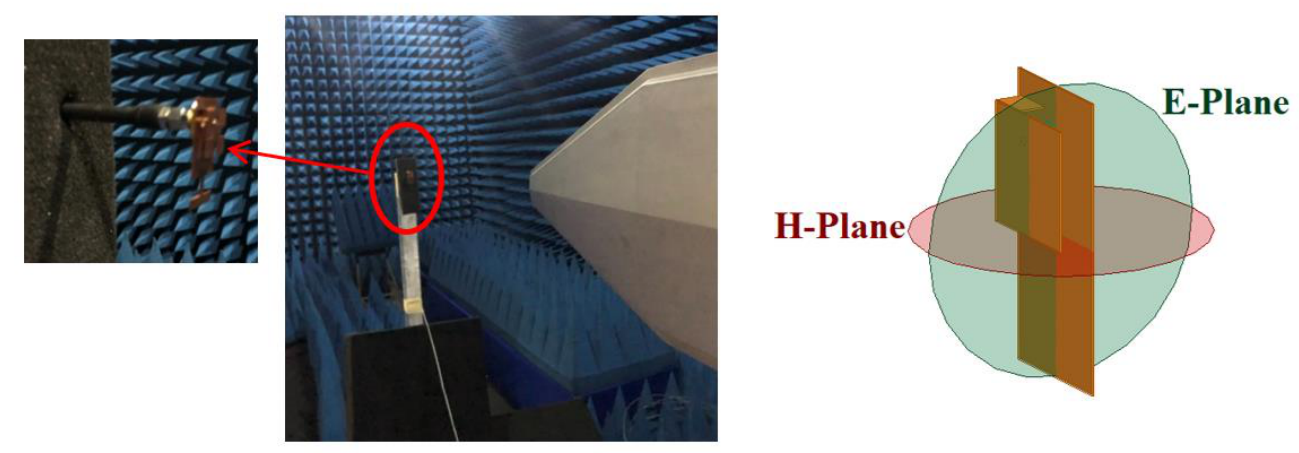
Figure 12. Measurement setup for PIFA gain measurements (anechoic chamber at the Microwave Laboratory of the University of Calabria) along with the definition of the E and H planes.